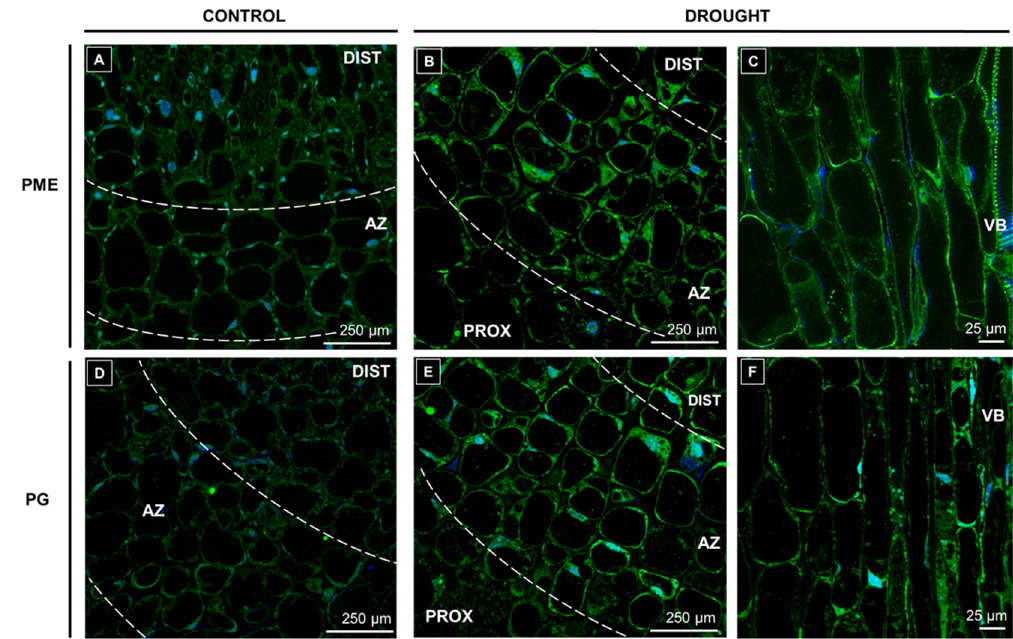
Figure 5. Drought influences the presence of pectin remodeling enzymes in the abscission zone (AZ) area. The impact of soil drought stress (25% WHC, water deficit conditions) on the localization of pectin-methylesterase (PME) ( B , C ) and polygalacturonase (PG) ( E,F ) was analyzed in the flower AZ of yellow lupine. Control was AZs excised from plants growing in the soil of optimal humidity (70% WHC) ( A , D ). For analysis, sections of AZs were collected on the 48th day of cultivation. Fixed material was dissected and incubated with monoclonal anti-PME-Ab ( A – C ) and anti-PG-Ab ( D – F ). Green fluorescence indicates the presence of the enzymes. Nuclei were stained with DAPI (blue fluorescence). AZ area is marked by white dotted lines ( A , B , D , E ). Abbreviations: DIST—a distal region of AZ, flower pedicel fragment above the AZ, PROX—a proximal region of AZ, stem fragment below the AZ, VB—vascular bundles. Bars are given in images.